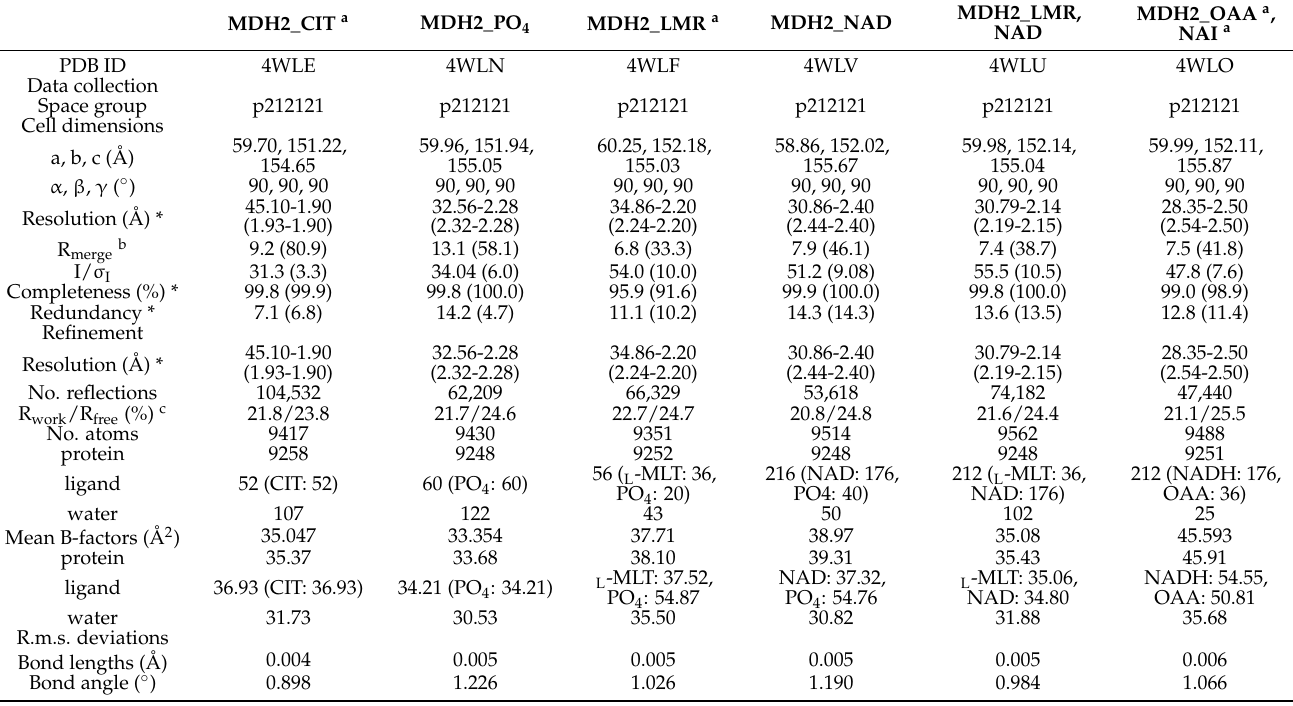
Table 1. Data collection and refinement